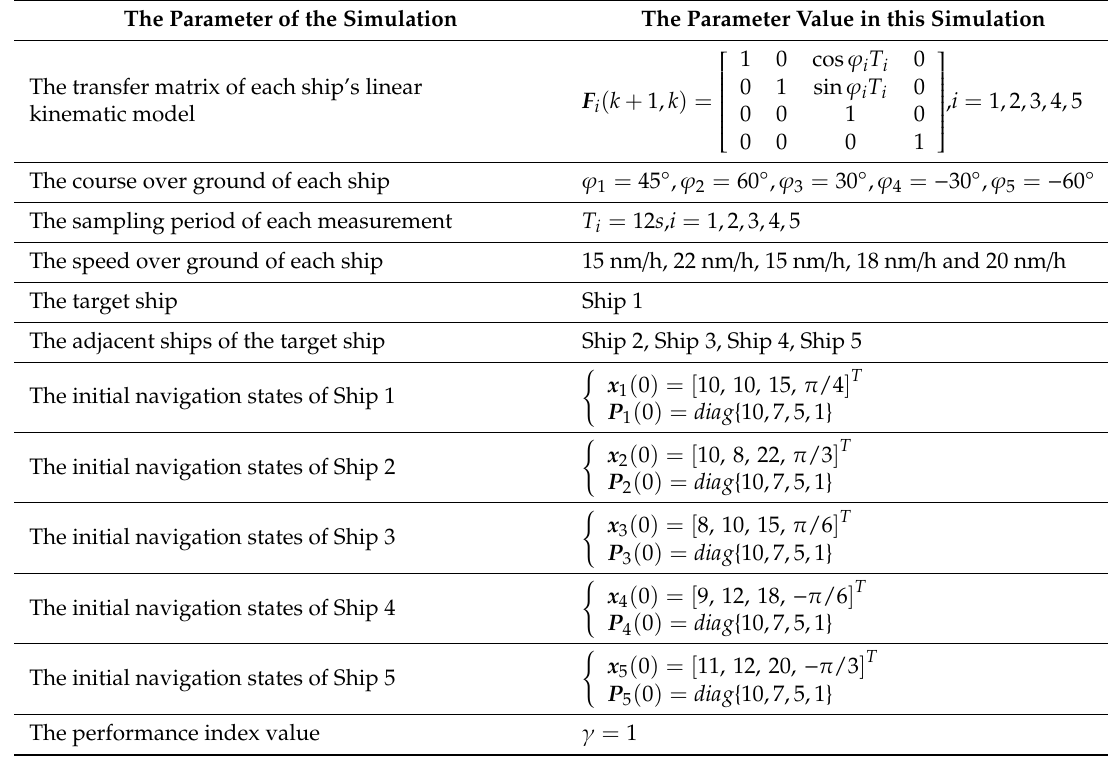
Table 1. The simulation